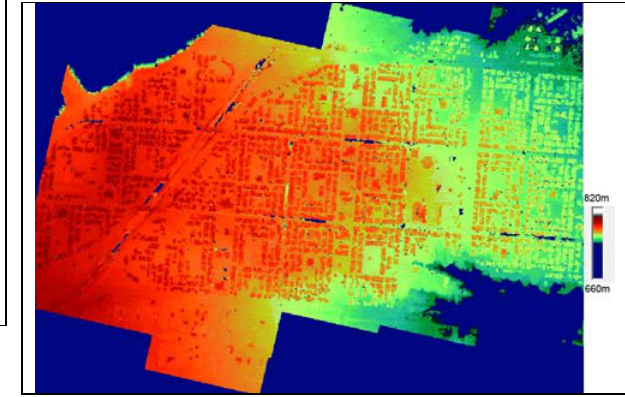
Figure 27: DSM differences – IKONOS DSM minus aerial photo DSM with 28cm GSD, DSM based on SGM